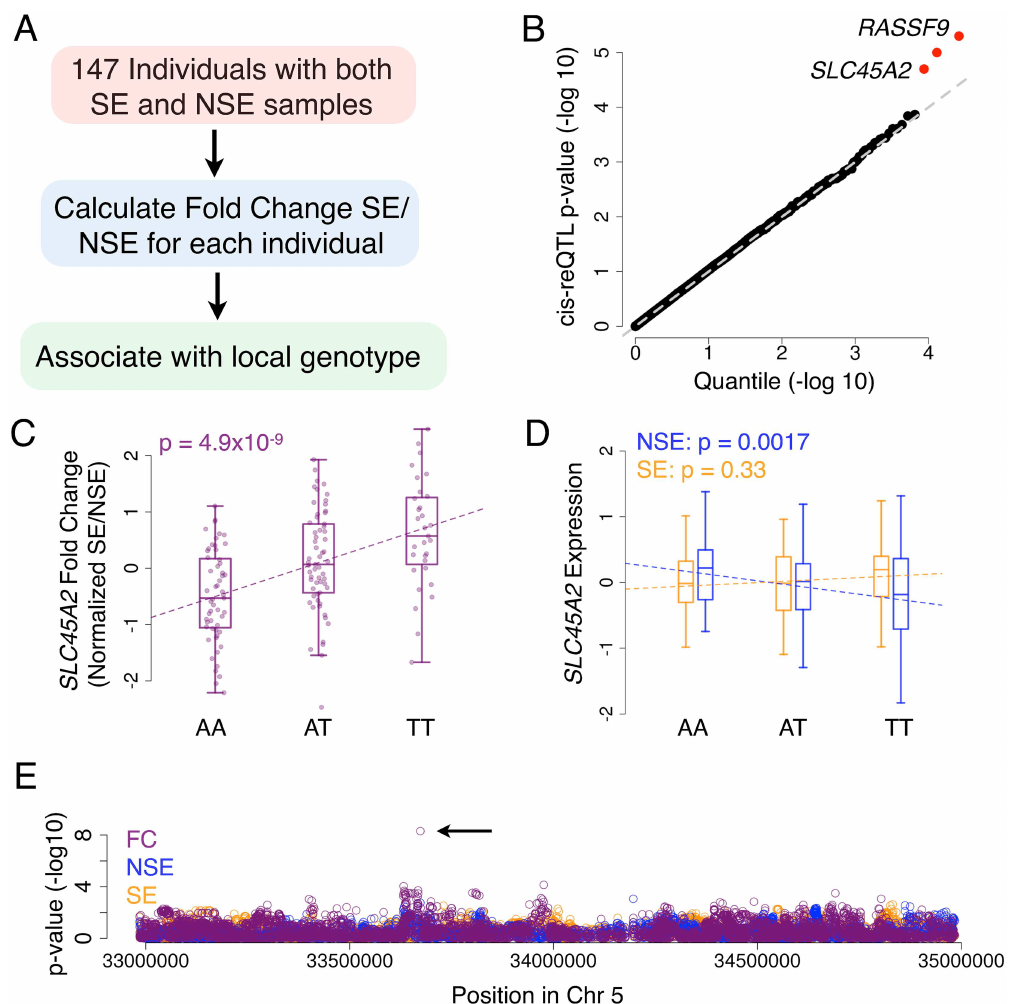
Fig 3. cis-reQTL mapping and SLC45A2 reQTL. (A) Outline of the approach for mappingcis-reQTLs (B) QQ plot of the cis-reQTL p-value for all genes tested. Red indicates the top 3 genes discussedin the text and used in subsequent analyses. (C) Normalized fold change of SLC45A2 expressionseparated by genotype at the cis-reQTL (rs12653176). p-valuecalculated from the Spearman correlation.(D) Normalized SLC45A2 expression of the NSE and SE samples separated by genotype at the same locus. p-values calculatedfrom the Spearman correlation. (E) Manhattan plot of the fold change(FC), NSE sample expression, and SE sample expression associations with all SNPs one megabase surrounding SLC45A2 . p-values calculated from the Spearman